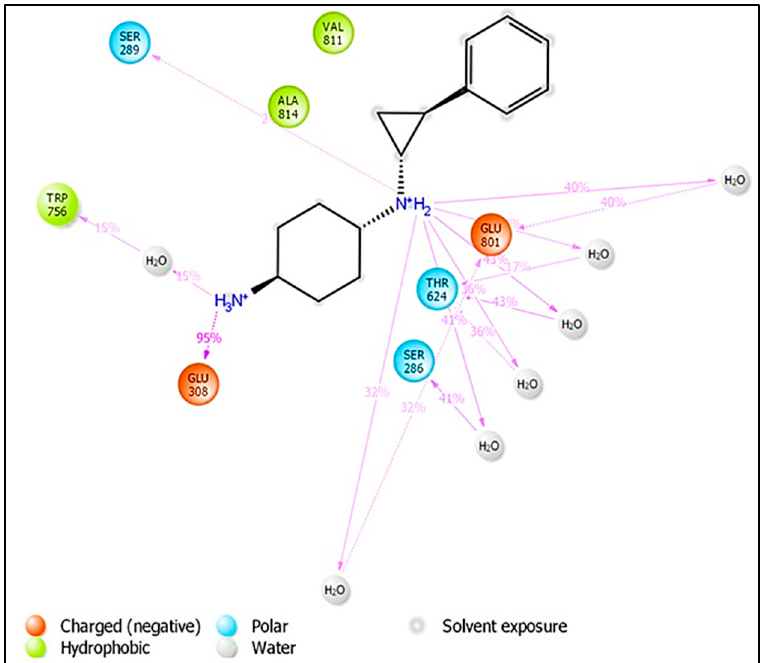
Figure 20. Ligand atom interactions with the protein residues LSD-compound 1 .